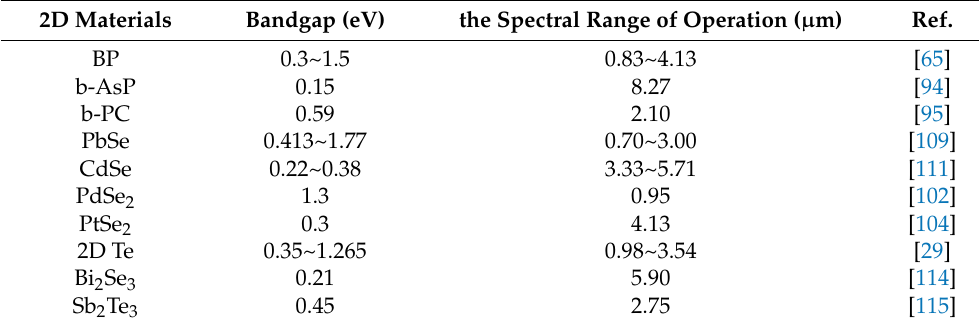
Table 1. The spectral range of the operation of some representative